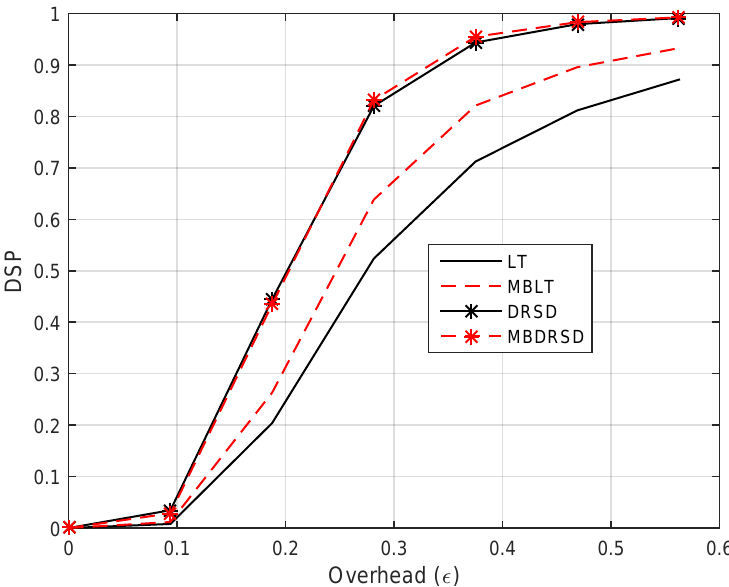
Figure 6. DSP versus the overhead ( (cid:101) ) for different coding schemes at k = 128 and erasure probabili- ties of ε 1 = 0, ε 2 = 0, and ε 3 =